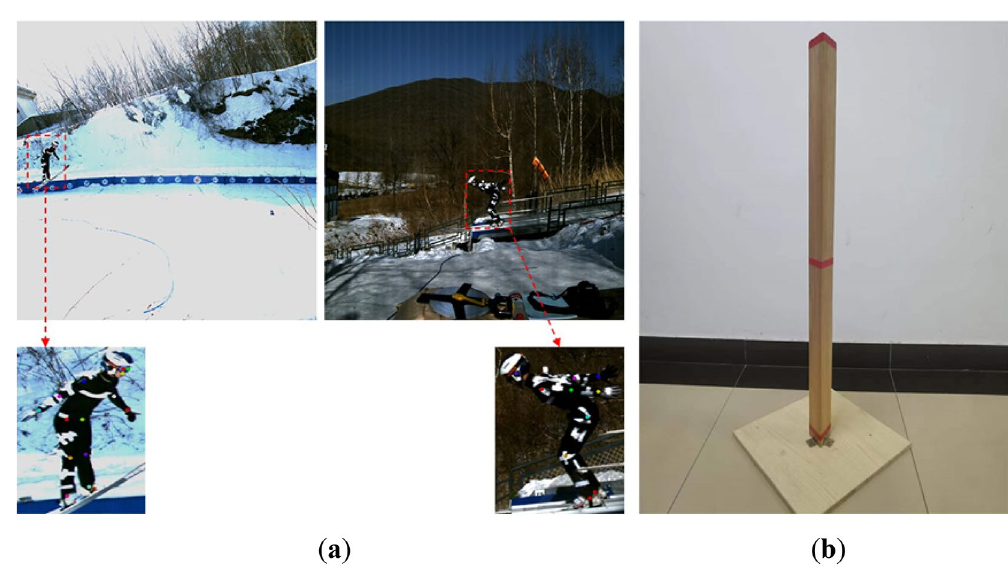
Figure 2. ( a ) Original image and local labeled keypoints of ski jumpers; ( b ) calibration